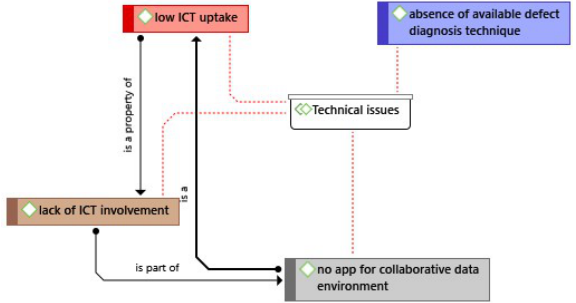
Fig. 9. Theme 6 (Technical-related